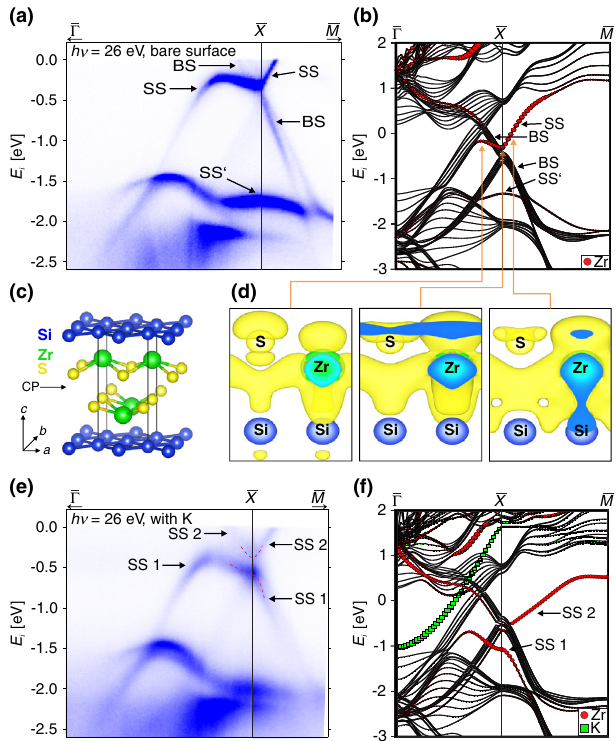
FIG. 2. Visualization of the surface states in ZrSiS. Panels (a) and (b) show dispersion plots along Γ X M . The path through the Fermi surface is shown in red in Fig. 3. (a) ARPES data of a bare surface, presenting the surface states (SS and SS 0 ) as high intensity features crossing the bulk bands (BS). (b) DFT slab calculations where the surface state character is indicated by the size of the red circles. (c) Crystal structure of ZrSiS. The unit cell is shown in black. The cleavage plane ( CP ) is indicated by a black arrow. (d) Isosurfaces of the charge density of the surface state at different k points. The arrows indicate the corresponding independent particle states in the band structure. Only the topmost layer of the supercell is shown because the charge density vanishes in the bulk. At the X point the surface state is mostly composed of Zr d z 2 and S p states. We find that the dispersion of the surface state towards Γ and M is linked to a change in Zr d , d , and d xz yz z 2 character. Panels (e) and (f) show dispersion plots along Γ X M for a potassium covered surface. Again, the red circles show the states arising from the surface termination in the calculations. The green squares in (f) show states that originate from an ordered array of potassium atoms on both sides of the slab. In (f), the relaxed z distance between K and the surface is 2.74 Å. The potassium mixes the orbital character of the surface bands, resulting in a gapping of the surface related bands (SS1 and SS2) in (e), which is reproduced, but overestimated, in the DFT calculations. For easier visibility, the red dashed line in (e) shows the band